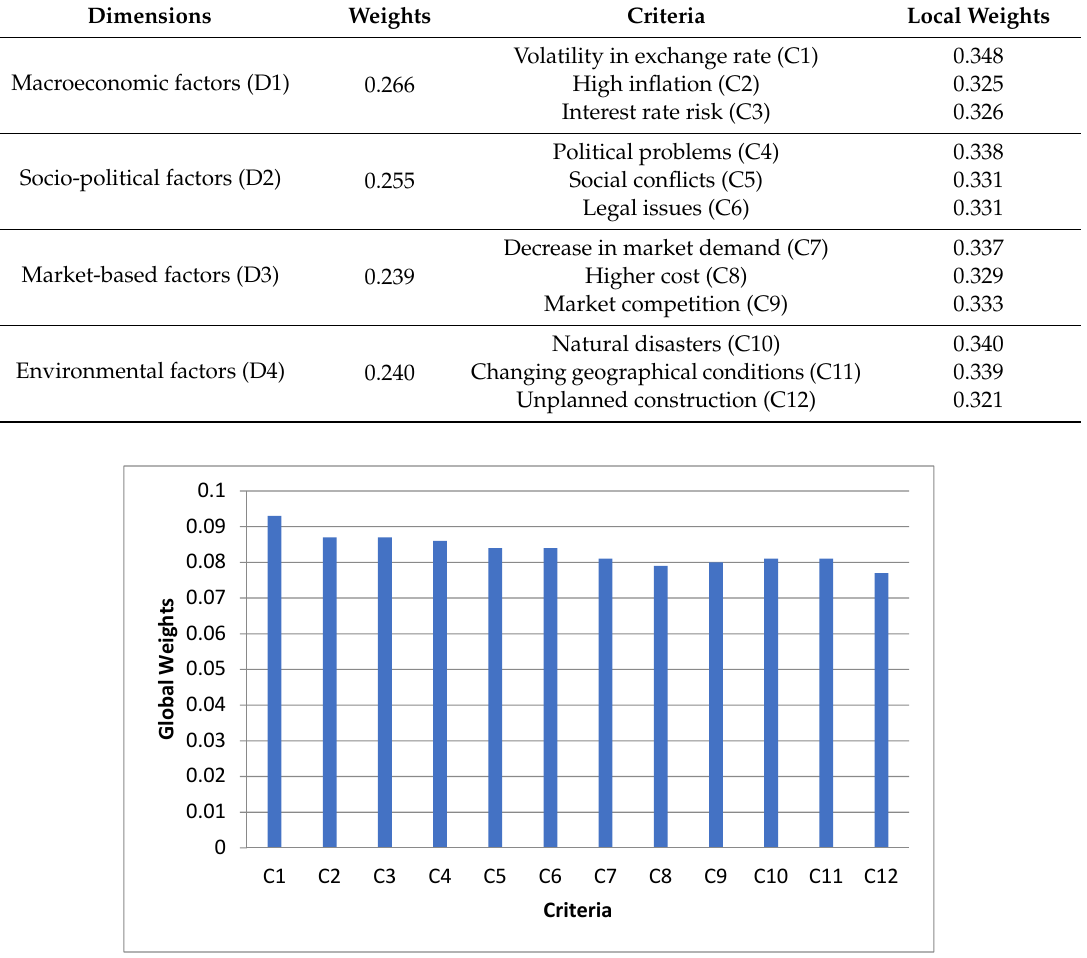
Figure 1. Global weights of the criteria.